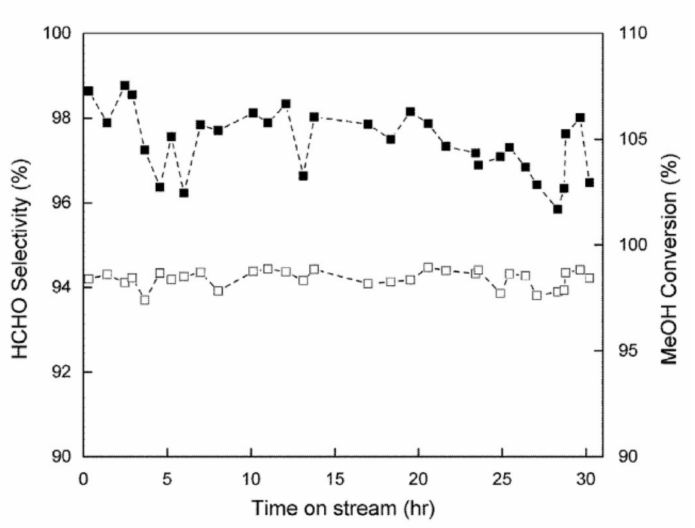
Figure 24. MeOH conversion ( (cid:3) ) and FA selectivity ( (cid:4) ) over NO-doped β -MoO 3 at 300 ◦ C W/F = 70 g cat /h/mol. Reprinted from [161] Copyright © (2016), with permission from